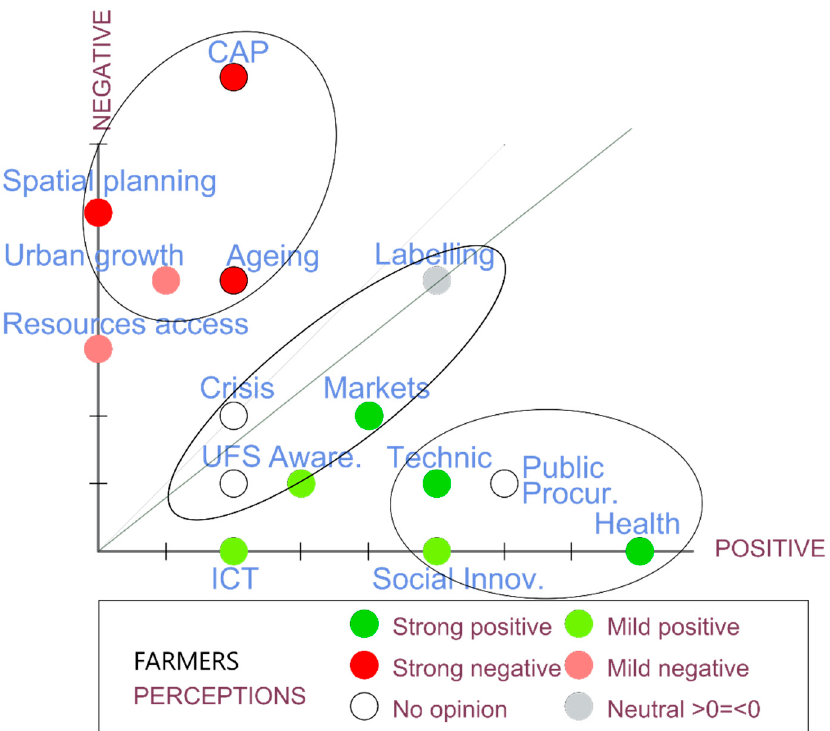
Figure 4. Perception of drivers and constrains, comparison between farmers and other stakeholders.